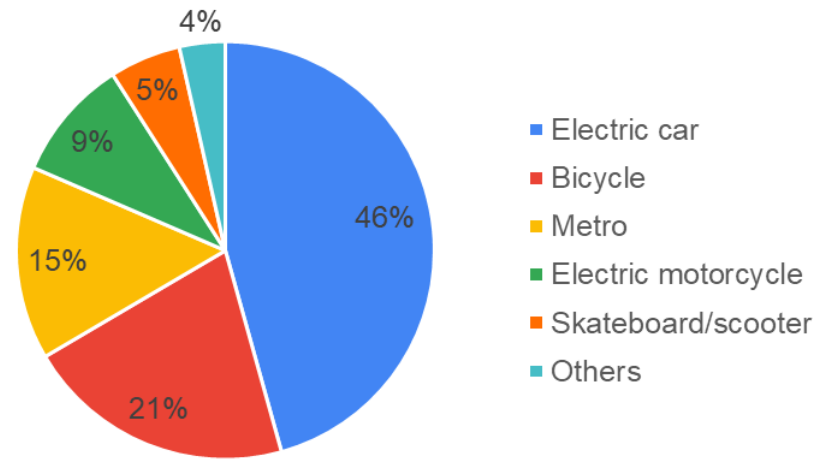
Figure 6. Alternative means of transport.